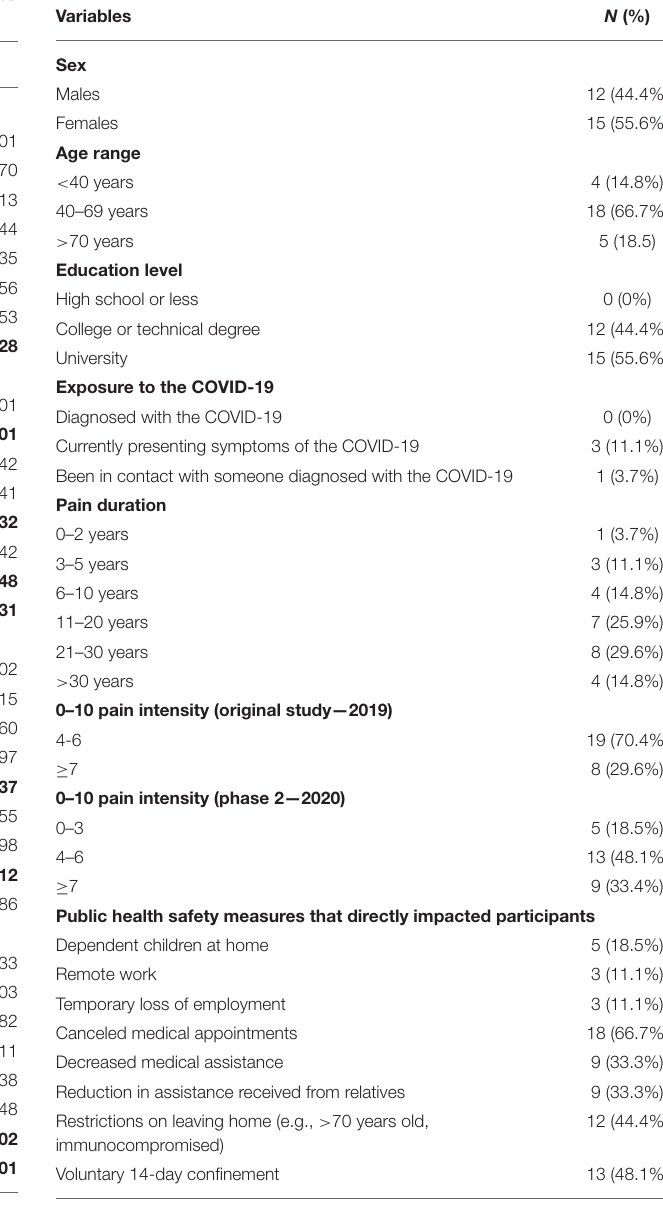
TABLE 4 | Participant characteristics of the qualitative study ( N =